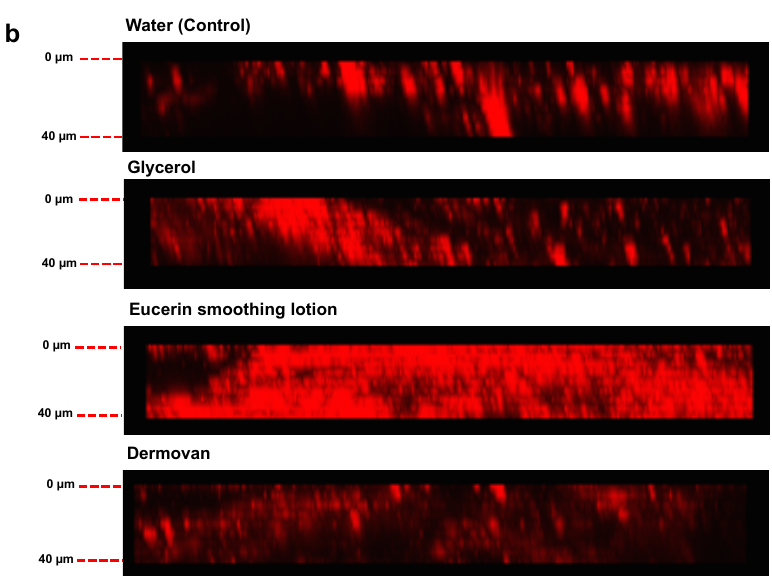
Figure 3. Eucerin Smoothing lotion enhances QD penetration through ex vivo human skin in the petri-dish protocol. ( a ) Significant increase in the QD presence was observed in the Eucerin smoothing lotion group at the depth of 10, 15, 30 and 35 µm compared to water treated group. All other vehicles exhibited QD penetration trends similar to the water; Mean ± SEM ( N = 4, n = 3); ( b ) three-dimensional reconstruction of the z-stacks (0–40 µm) obtained by using CLSM shows that QDs do not penetrate skin by a uniform Fickian diffusion process. QDs appear to penetrate into the viable epidermis though high fluency entry points in the stratum corneum. The data suggest that much more penetration is evident in human skin compared to mouse skin. * p < 0.05 vs. water.